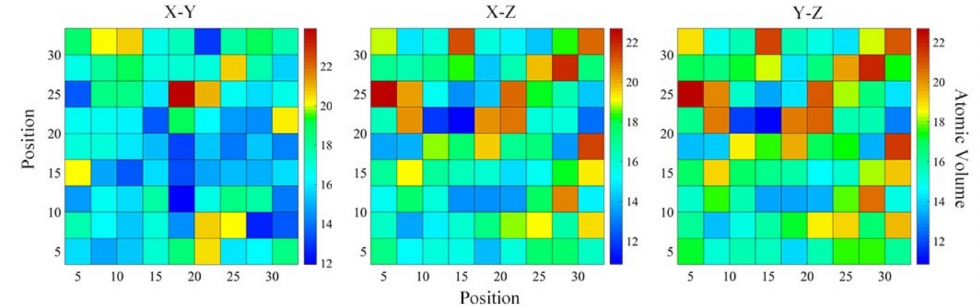
Figure 9. The distribution of atomic volumes along z-, y-, and x-axis in Ti 15 Nb 45 Al 40 glassy alloys, respectively.